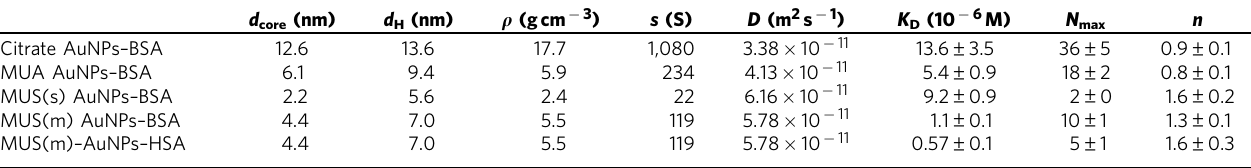
Table 3 | Interaction parameters obtained from AUC for various types of AuNPs and proteins. d core (nm) d H (nm) q (gcm (cid:2) 3 ) D (m 2 s (cid:2) 1 ) n Citrate